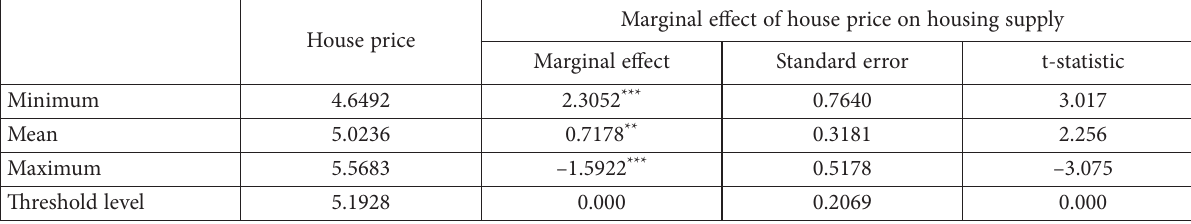
Table 7. Marginal effect of house price on housing